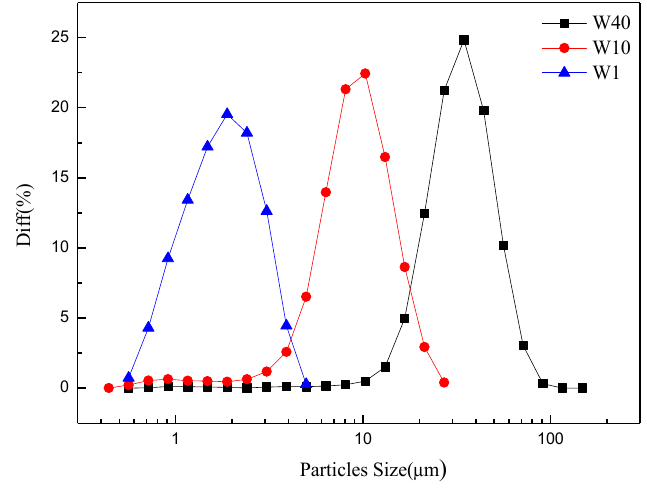
Figure 1. Particle size distribution of W40, W10 and W1 powders.